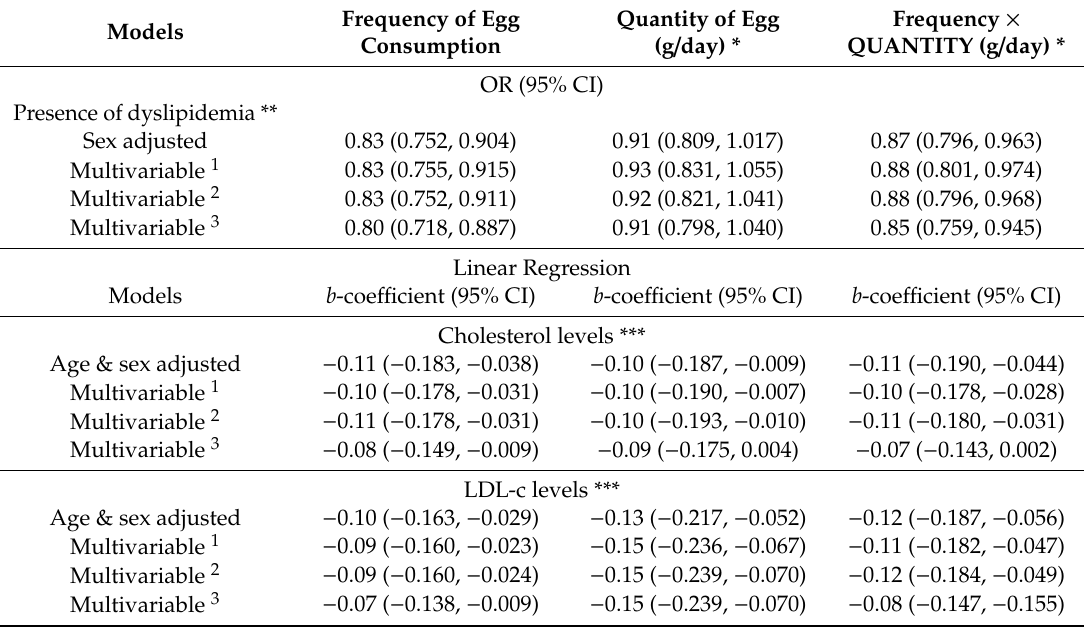
Table 3. Linear and logistic regression analysis of lipid levels and status and egg consumption by reported frequency, quantity, and frequency with